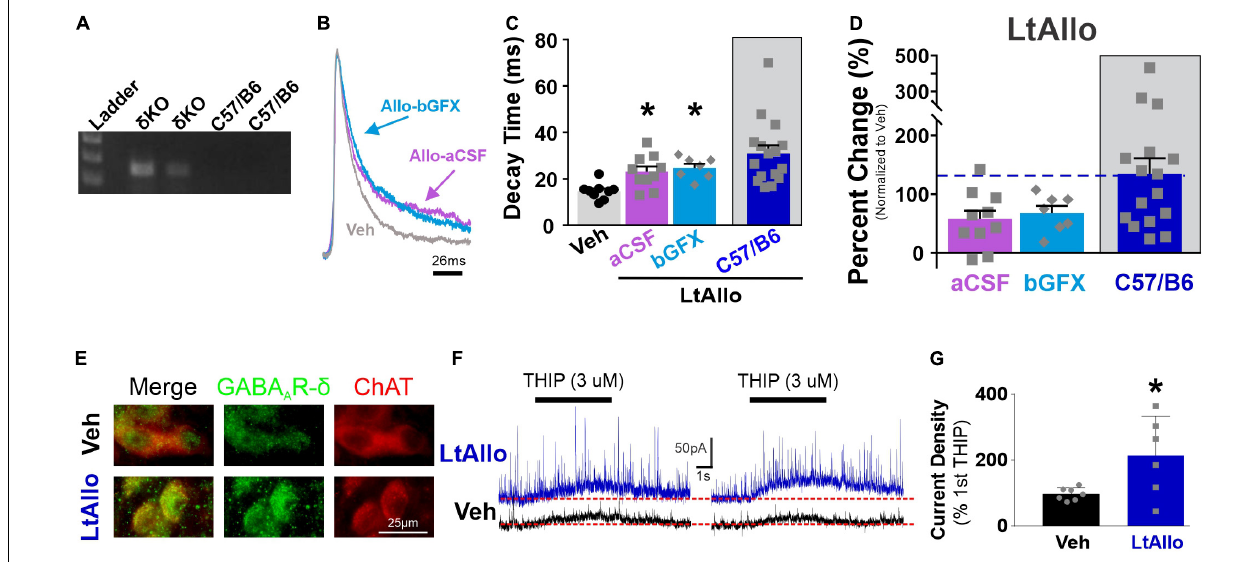
FIGURE 5 | PKC-dependent effects of LtAllo require the GABA A receptor’s δ -subunit. (A) Representative genotype from the C57/Bl6J and GABA A receptor δ -subunit knockout mice (Gabrd − / − , δ KO). (B) A representative averaged trace of sIPSCs in a DMV neuron from a δ KO mouse during Veh (gray trace), Allo-aCSF (pink trace), and Allo-bGFX (light-blue trace). Averaged traces were normalized for amplitude to emphasize decay time. (C) Mean ± SEM of sIPSC decay time in DMV neuron from δ KO mice from Veh (14.7 ± 1.2 ms; n = 9 from 6 mice), LtAllo (aCSF; 28.53 ± 5.8 ms; n = 11 from 4 mice), LtAllo + bGFX (28.7 ± 4.3 ms; n = 8 from 3 mice). LtAllo-aCSF in C57/B6 has been duplicated from Figure 1 . One-way ANOVA with Tukey’s post hoc . (D) Mean ± SEM of sIPSC decay time relative change to the average Veh condition decay time in DMV neuron from δ KO mice during LtAllo-aCSF (94.1 ± 39.8%; n = 11 from 4 mice) and LtAllo-bGFX (95.5 ± 29.3%; n = 8 from 3 mice). LtAllo-aCSF in C57/B6 has been duplicated from Figure 1 . Unpaired Student’s t -test. (E) Immunofluorescence microscopy image of the δ -subunit of the GABA A receptor (green) and choline acetyltransferase (ChAT; red) immunoreactivity following from Veh ( n = 4) or LtAllo ( n = 4) treated DMV neurons in C57/Bl6 mice. (F) Responsivity of the δ -subunit of the GABA A receptor was assessed by 4,5,6,7-tetrahydroisoxazolo[5,4- c ]pyridin-3-ol hydrochloride (THIP; a δ -subunit agonist) dual-activation in DMV neurons from C57/Bl6 mice. Representative traces demonstrate THIP-inducible current during initial (left panel) and secondary (right panel) picospritzed application of THIP (3 µ M; 5 s; 20 min interval) in a DMV neuron during Veh (black traces) or LtAllo (blue traces). Change in inducible-current density (pA/pF) was measured as the amplitude difference from baseline steady-state holding current (denoted by dashed line) following the secondary application of THIP relative to the 1st application of THIP, expressed as the percentage. (G) Mean ± SEM of change in THIP-inducible current density in DMV neurons from Veh-treated (97.1 ± 7.2%; n = 7 from 3 mice) and LtAllo-treated (213.4 ± 48.9%; n = 6 from 3 mice). Overlaid points denote